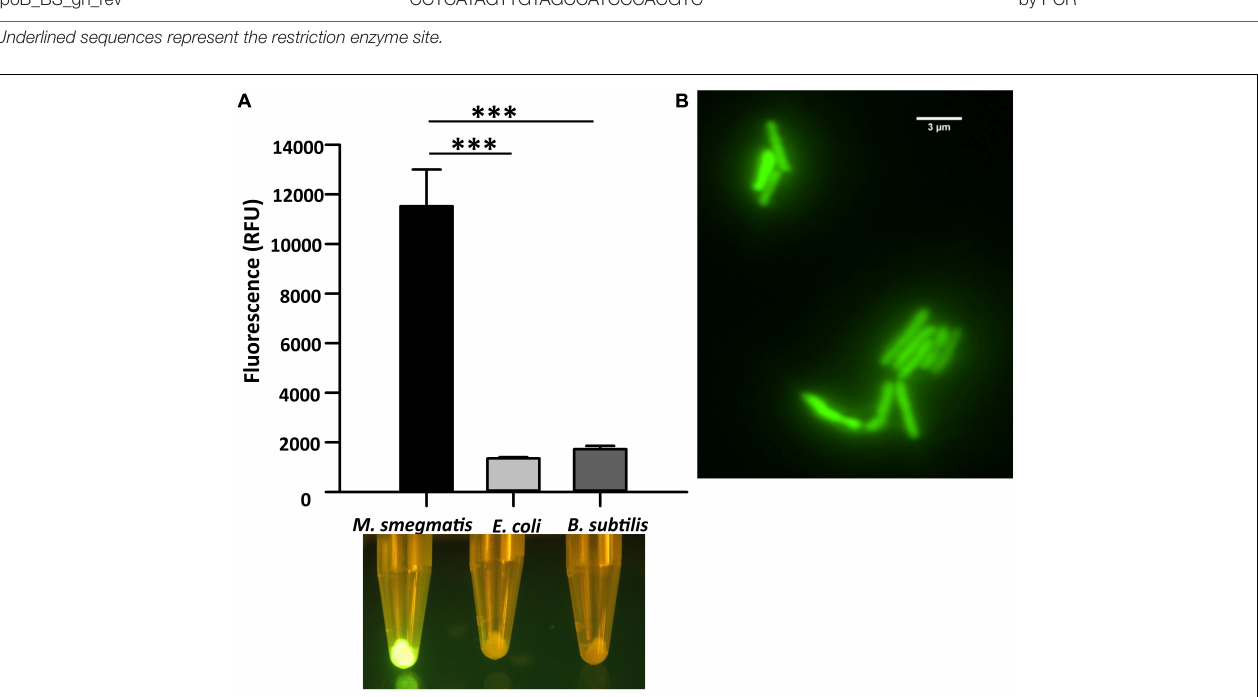
FIGURE 1 | Cell binding assay of CTD-GFP with different bacterial cells. (A) The relative fluorescence obtained for CTD-GFP bound to M. smegmatis , E. coli , and B. subtilis cells. Fluorescence was measured by keeping the excitation and emission wavelengths at 488 and 509 nm, respectively. The data represent an average of three experiments with error bars denoting the standard deviation ( p -value analysis: ∗∗∗ , < 0.0003). The bottom panel shows the image of fluorescing cell pellet obtained after illuminating it with a blue light ( ∼ 470 nm) source. (B) Fluorescence microscopy imaging of CTD-GFP bound M. smegmatis cells. The image was taken on a Leica Microsystems fluorescence microscope with a GFP